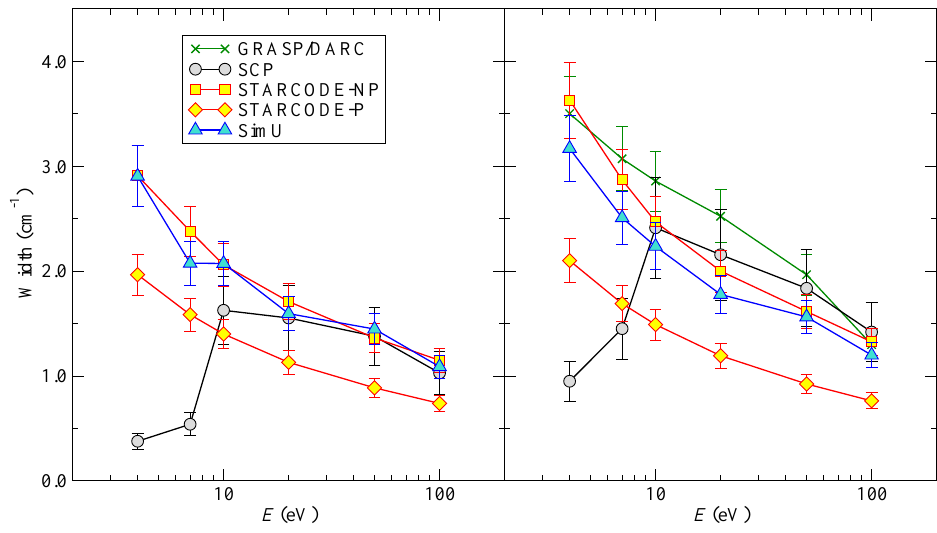
Figure 8. B III 2 s − 2 p FWHM as a function of the energy E . ( Left ) only the dipole interaction is taken into account; ( Right ) the dipole and quadrupole interaction are both taken into